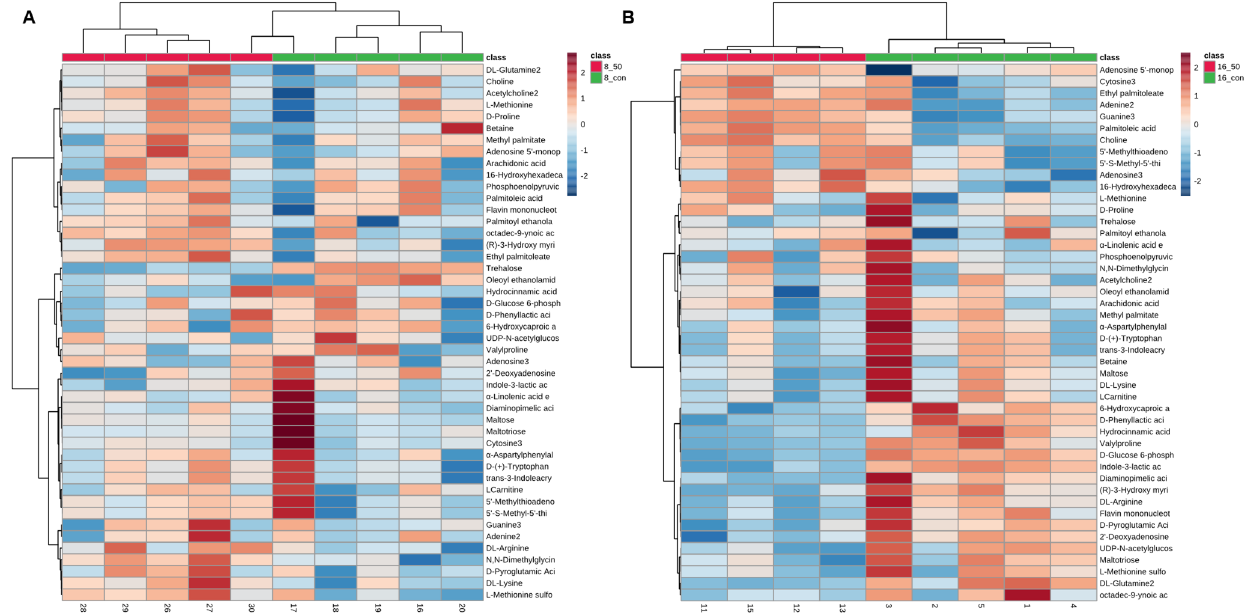
Figure 5. Heat map of endogenous differential metabolites based on PAT exposure. The 8 h group ( A ) and the 16 h group ( B ). These data are conditioned by p < 0.05, fold change (FC) > 1.2, and projection value (VIP) > 1 screening criteria.